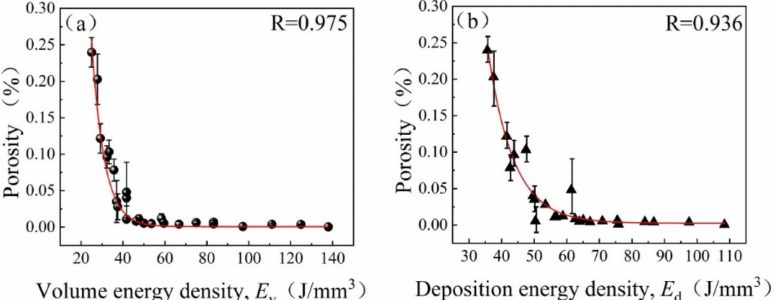
Figure 5. Change in the porosity as a function of ( a ) volume energy density and ( b ) deposition energy